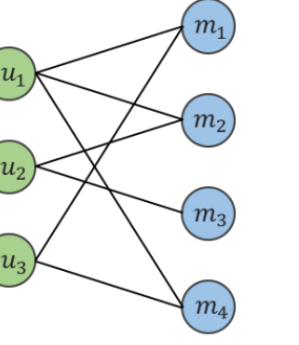
Figure 4. An example of ‘shop–shop’ single vertex set network.